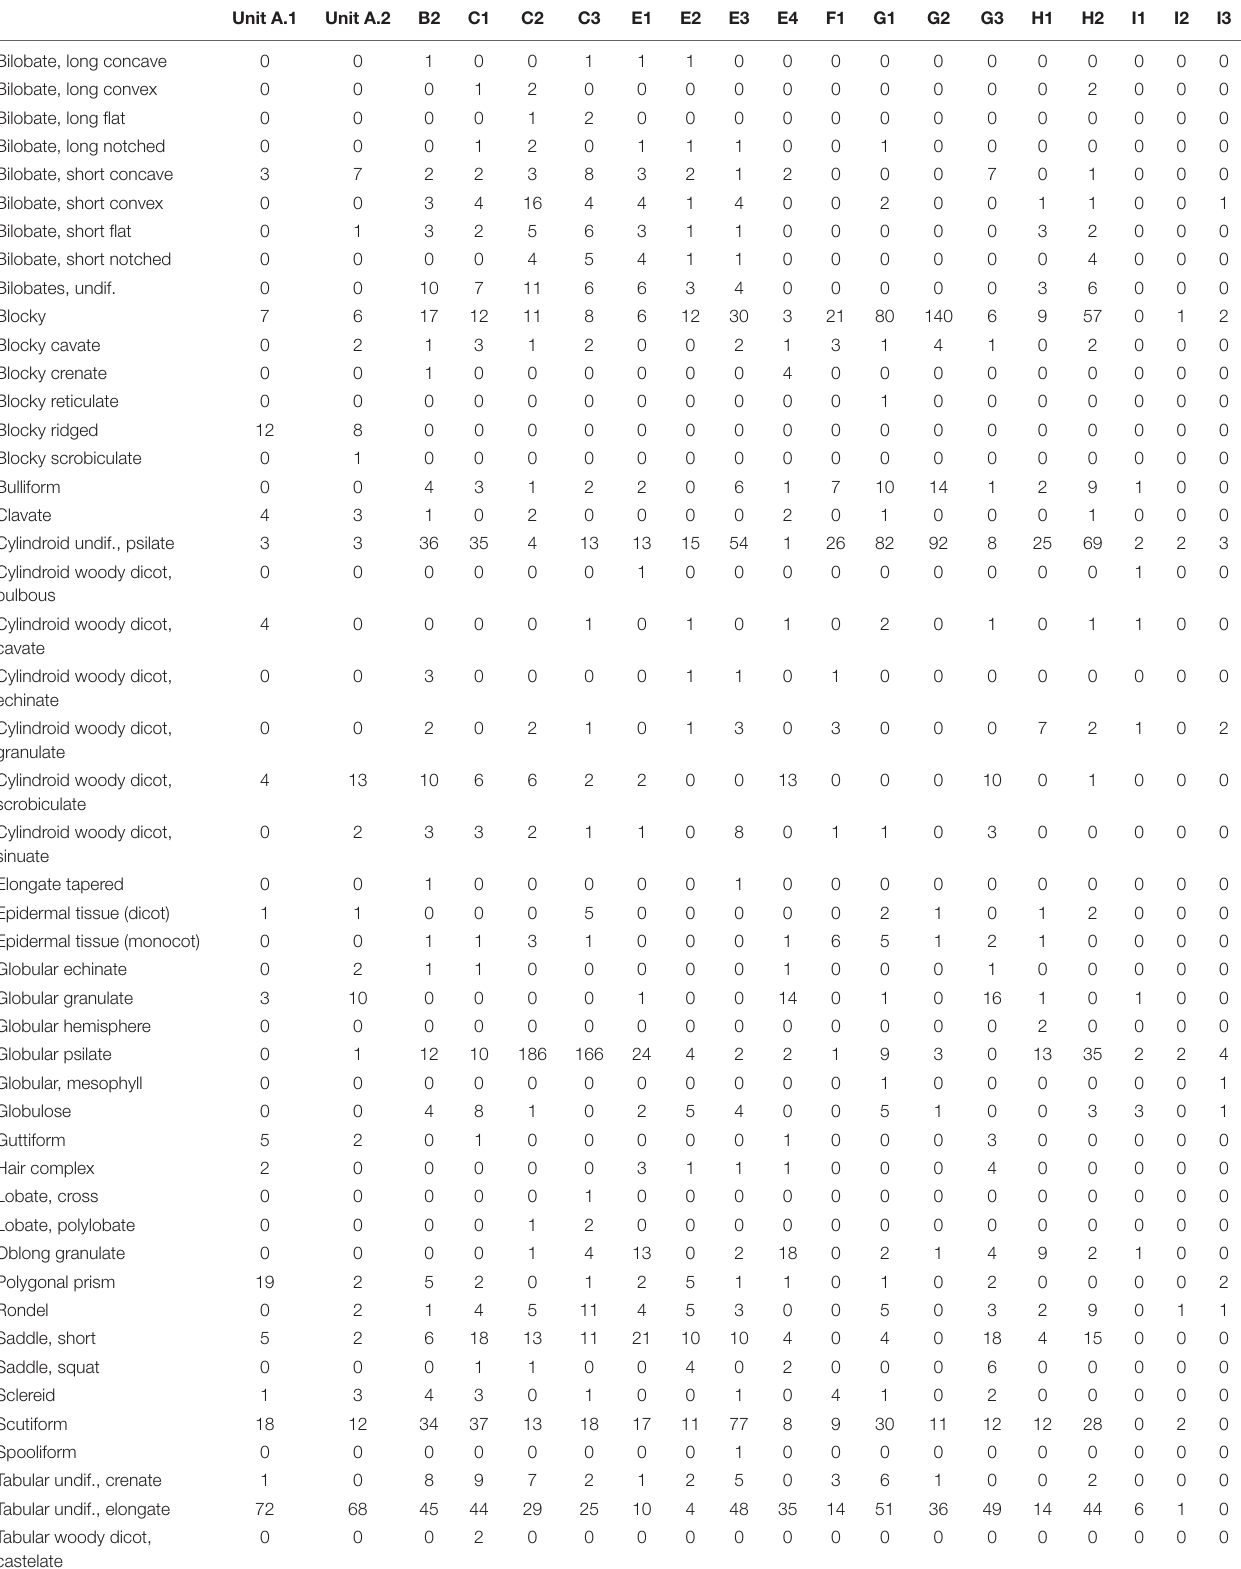
TABLE 2 | Phytolith counts per sample and morphotype identified at